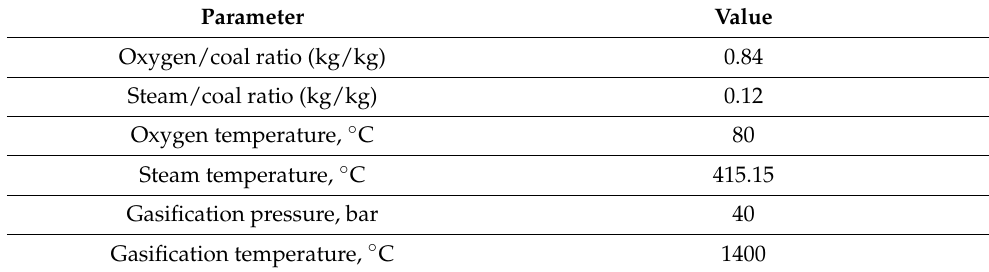
Table 3. Operation parameters of gasifier.